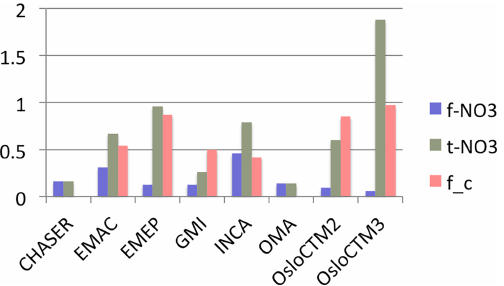
Figure 10. NO − fine-mode burden (f-NO 3 , Tg), total burden (t- 3 NO 3 , Tg), and coarse-mode fraction (f_c) for the eight AeroCom